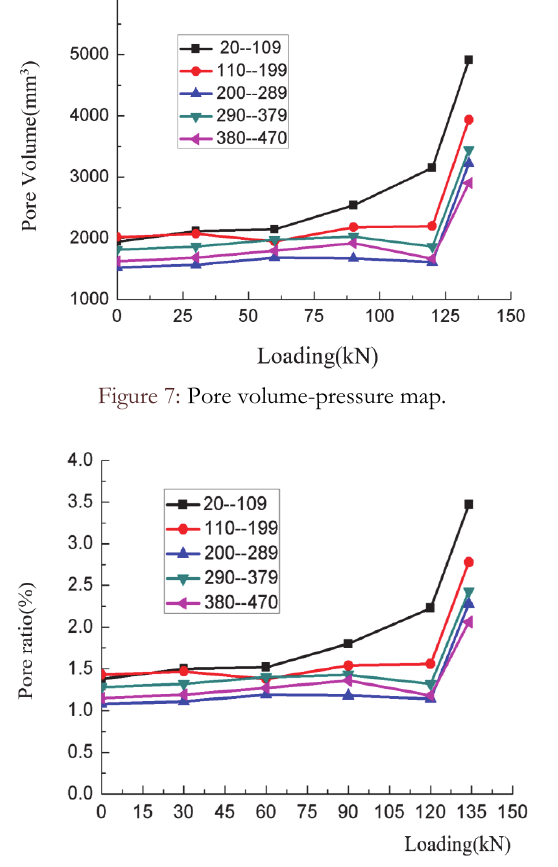
Figure 8: Pore ratio change with loading.